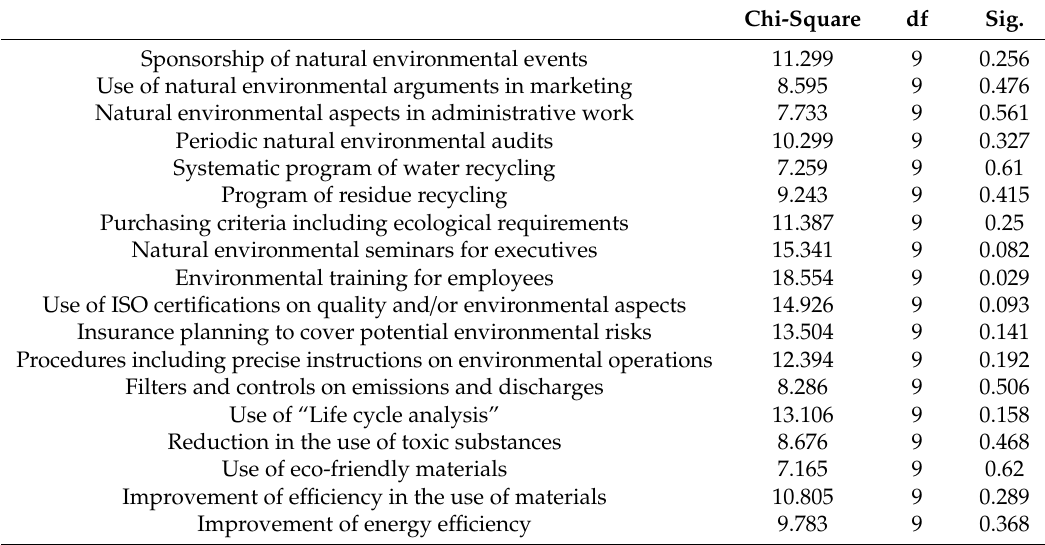
Table A2. Kruskal–Wallis test p